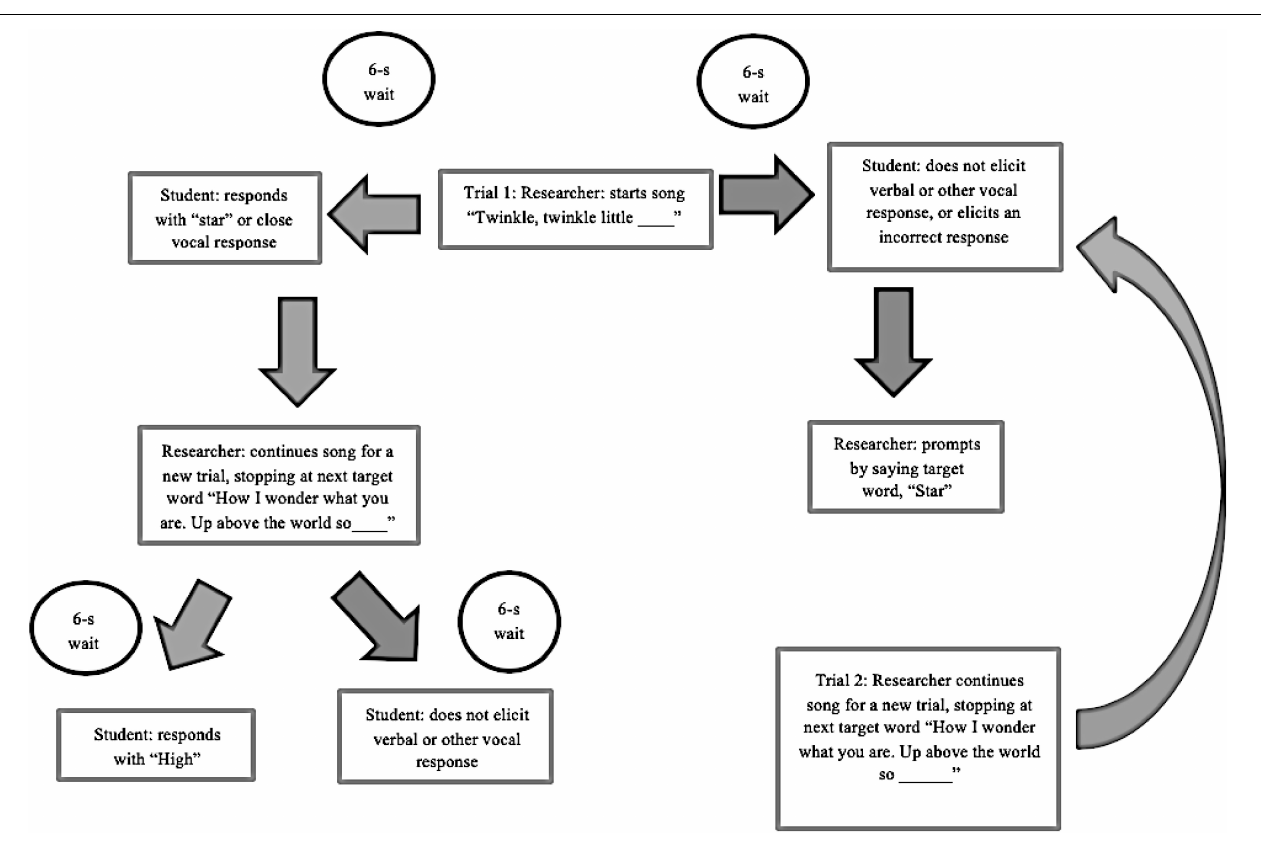
FIGURE 1 | Diagram for the ABA/music